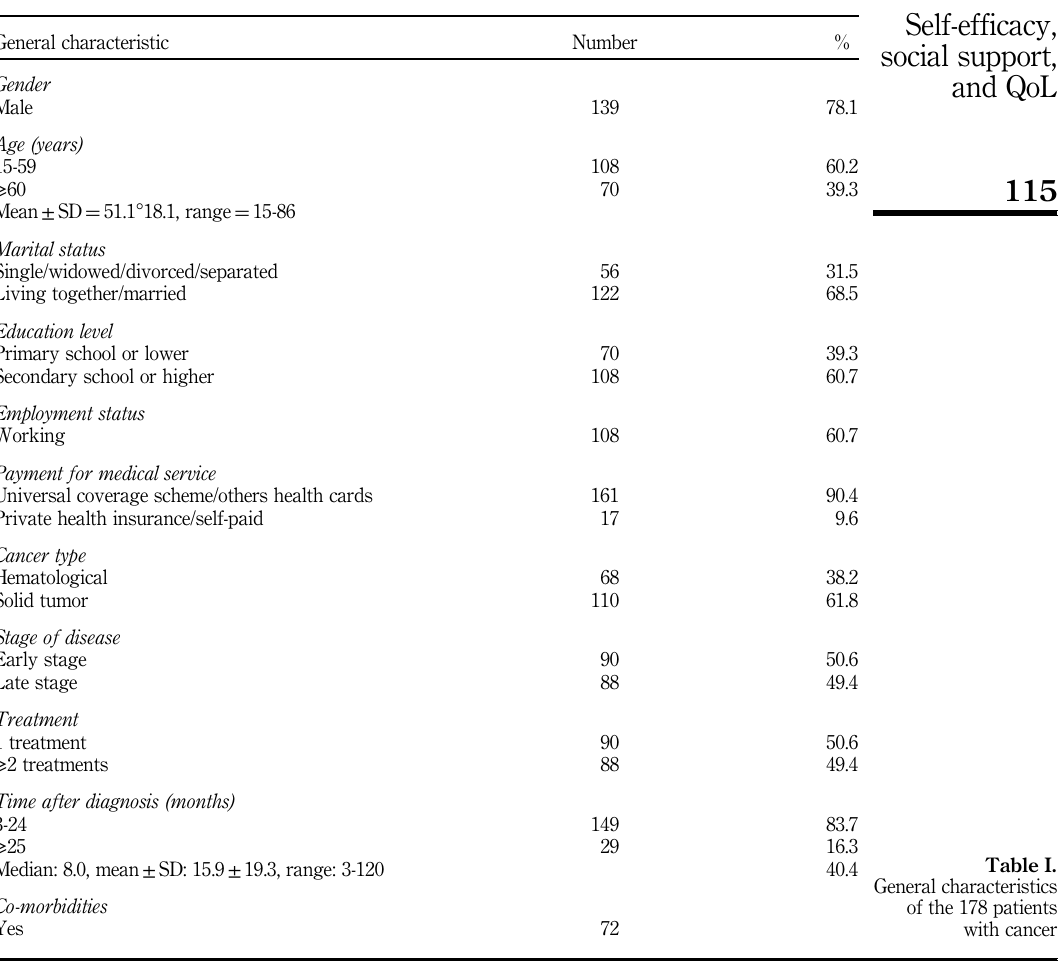
Table I. General